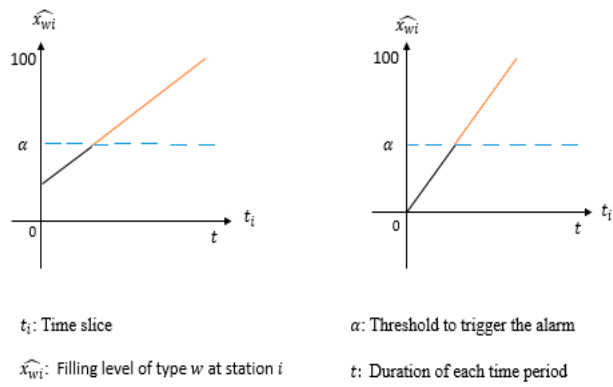
Figure 2. Fill level of each type in each station.